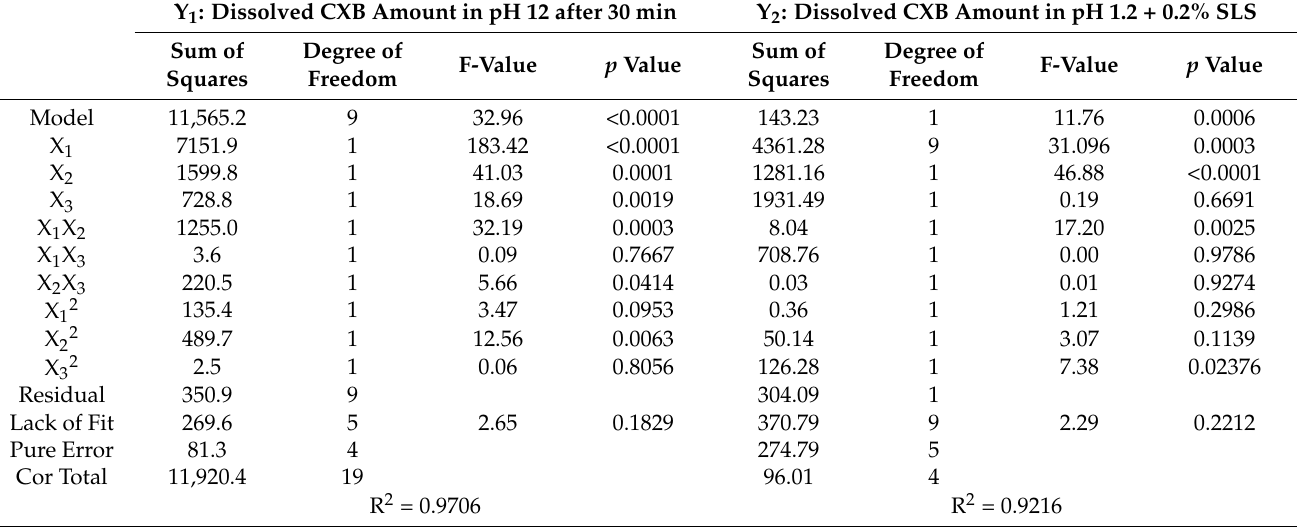
Table 5. Summary of the ANOVA for responses Y 1 and Y 2 in the quadratic